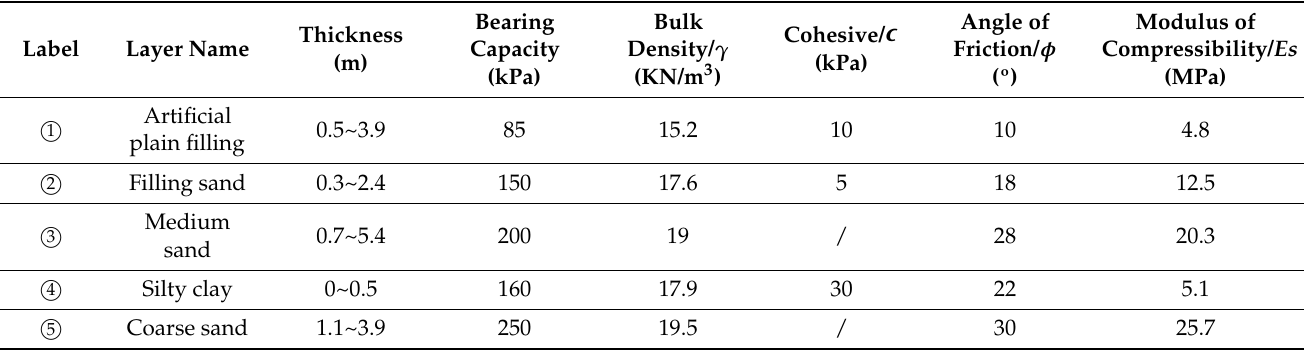
Table 1. Soil layer distribution and engineering properties.